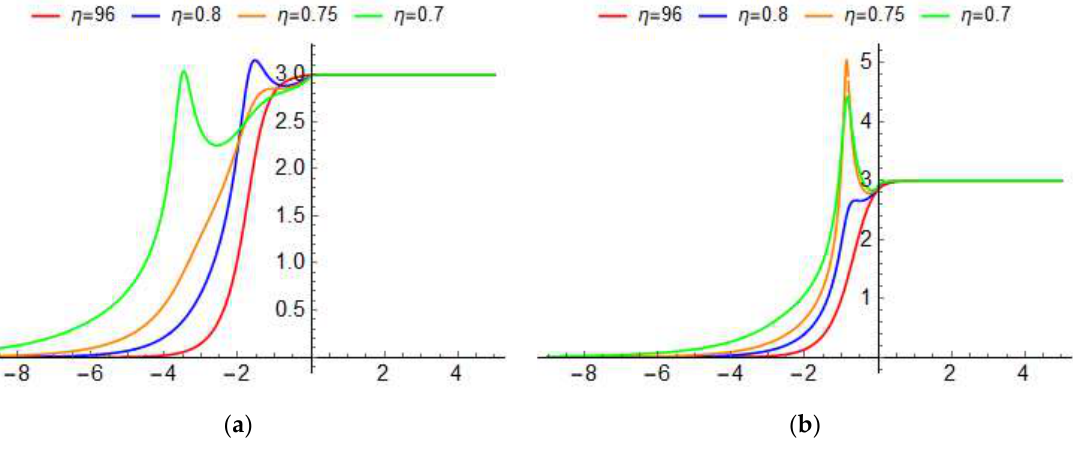
( 𝑥, 𝑡 )(cid:3627) in (35) where 𝑎 8